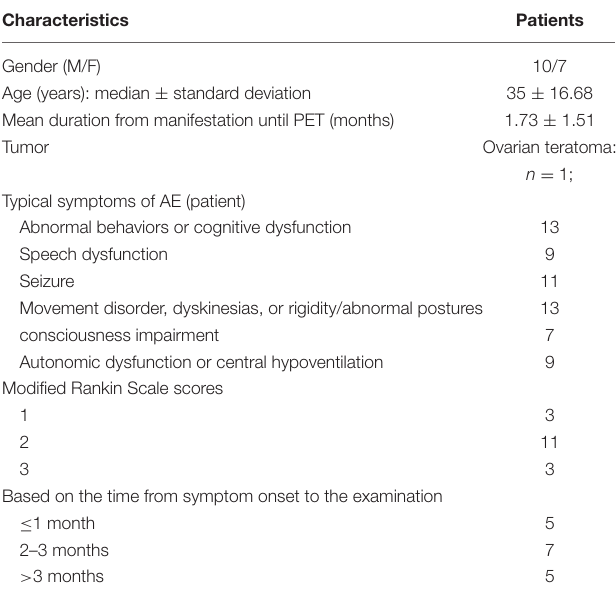
TABLE 1 | Summary of clinical data of all patients.